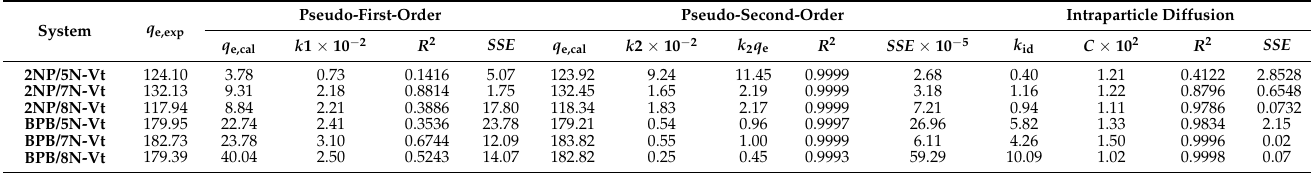
Figure 5. The effects of time on 2-NP and BPB adsorption ( a , d ), PSO kinetic models ( b , e ) and IPD models ( c , f ). Table 2. Kinetic parameters for the adsorption of 2-NP and BPB for